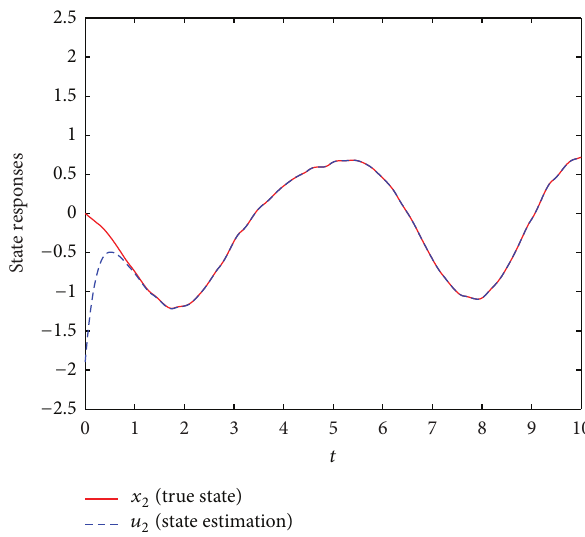
Figure 3: The responses of the true state 𝑥 2 (𝑡) (solid line) and its estimation 𝑢 2 (𝑡) (dash